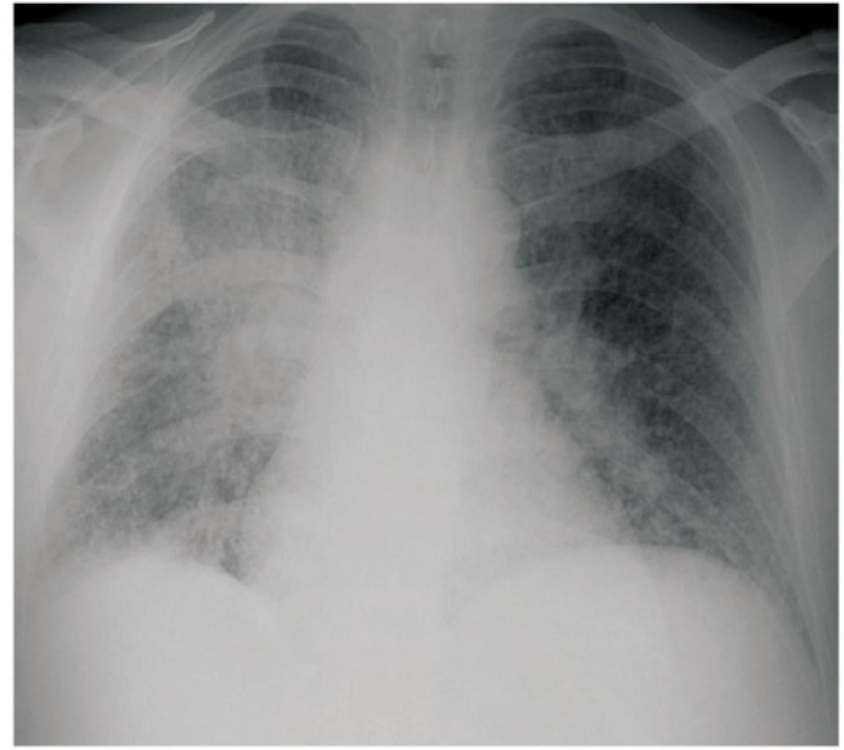
Figure 2. Pulmonary blastomycosis chest X-ray image. Chest X-ray seen in a patient with pulmonary blastomycosis demonstrating a right lower lobe consolidation and bilateral military nodules.